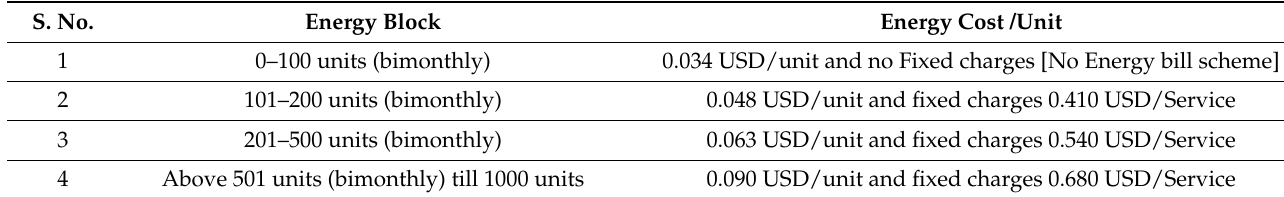
Figure 20. Hybrid sources supporting the demand side management technique. Table 5. Domestic consumer energy tariff rates at the proposed